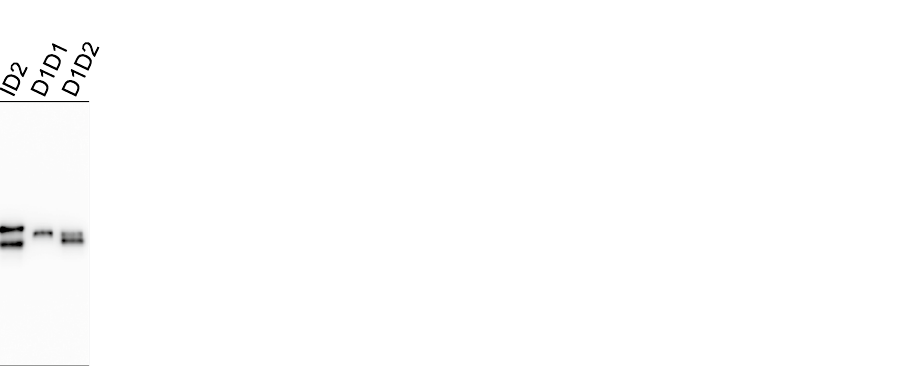
Figure 4. Molecular weight and migration pattern of plasma eHRG with 5 genotypes. Plasma of each genotype was selected from the genotyping results and eHRG protein was detected by western blotting. Shown are presentative photo of five independent experiments. The numbers on the left are molecular weight markers. II: Insertion/insertion, ID1: insertion/45 bp deletion, ID2: insertion/90 bp deletion, D1/D1: 45 bp deletion/45 bp deletion, D1D2: 45 bp deletion/90 bp